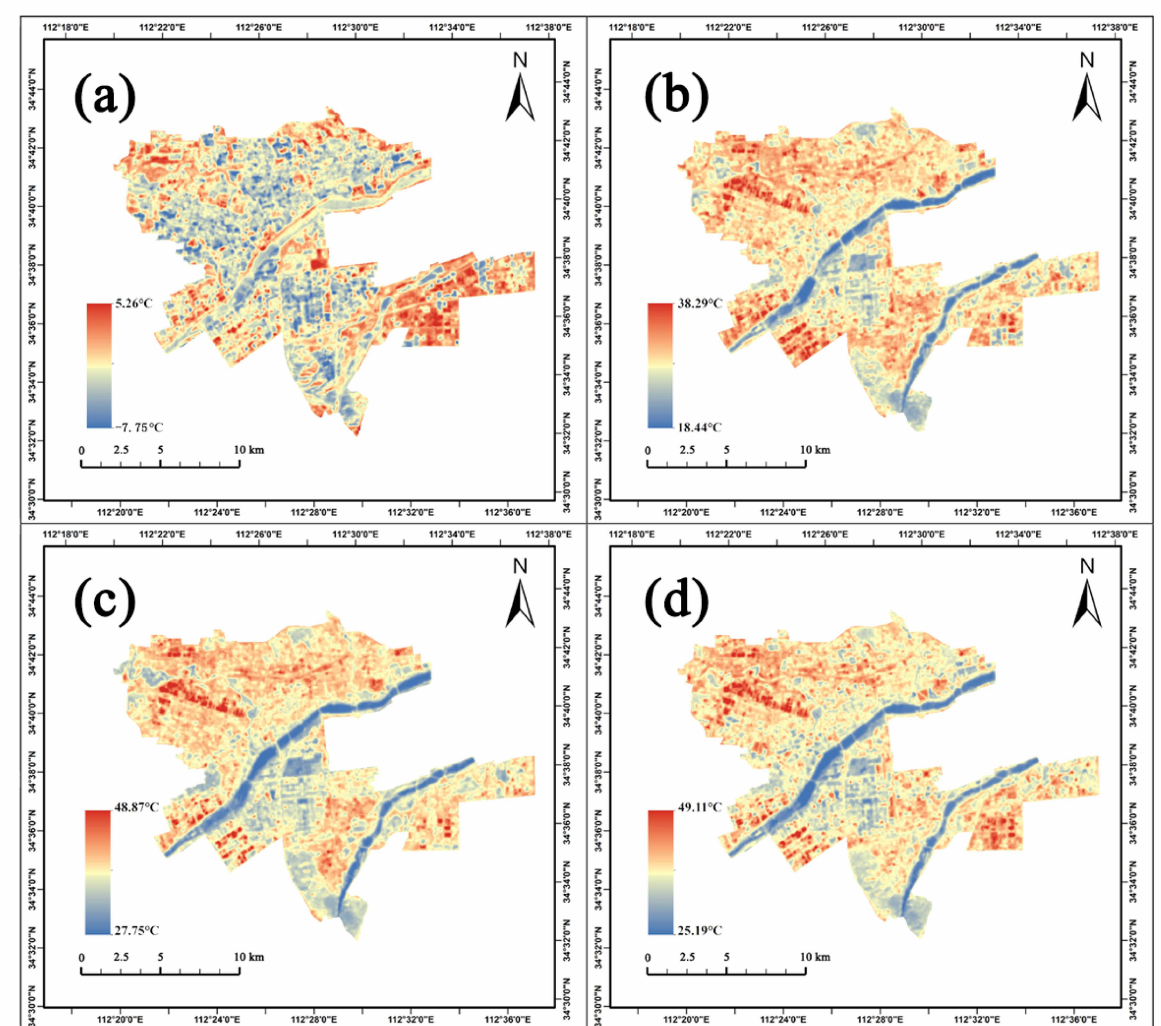
Figure 4. Spatial distribution of land surface temperature (LST). ( a ) LST in winter ( b ) LST in spring ( c ) LST in summer ( d ) LST in